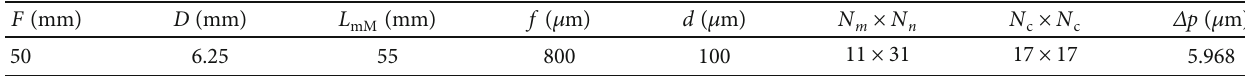
Figure 7: The original temperature pro fi le of the axisymmetric fl ame. Table 1: The main parameters of the light fi eld